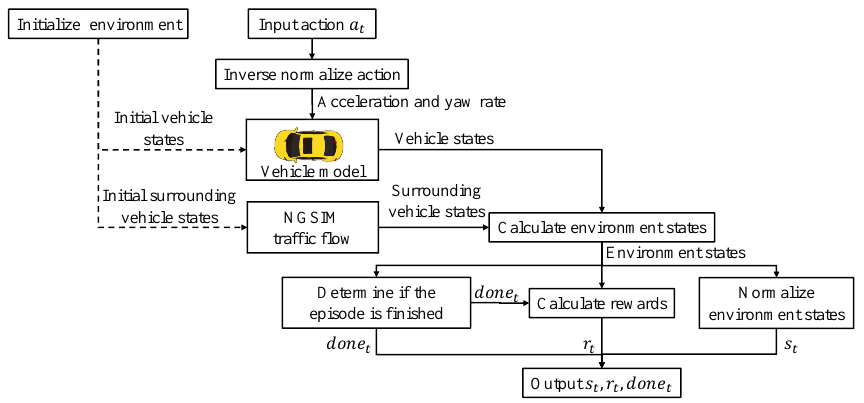
Figure 9. Interactive environment for reinforcement